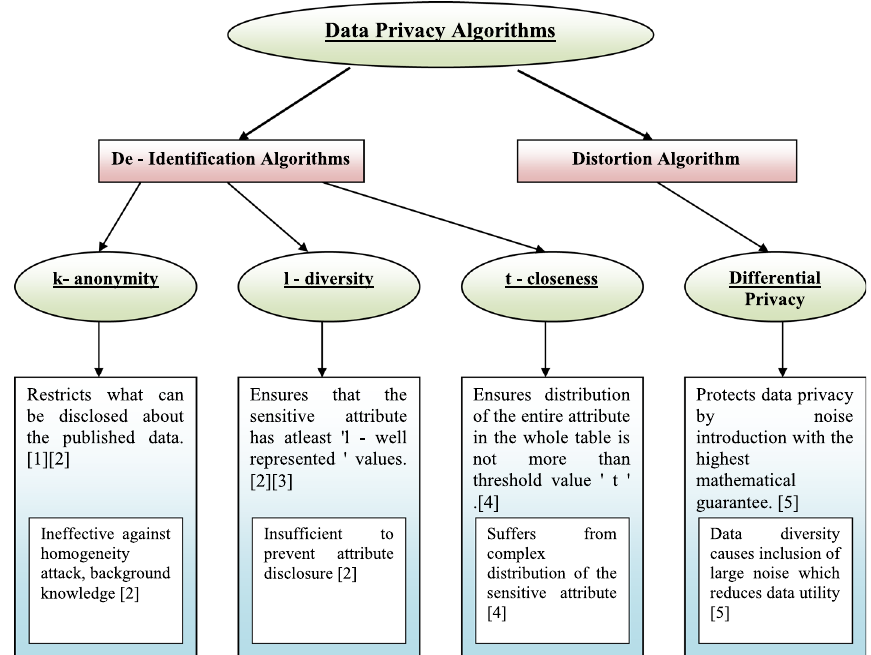
Fig. 1 Pros and cons of classical data privacy